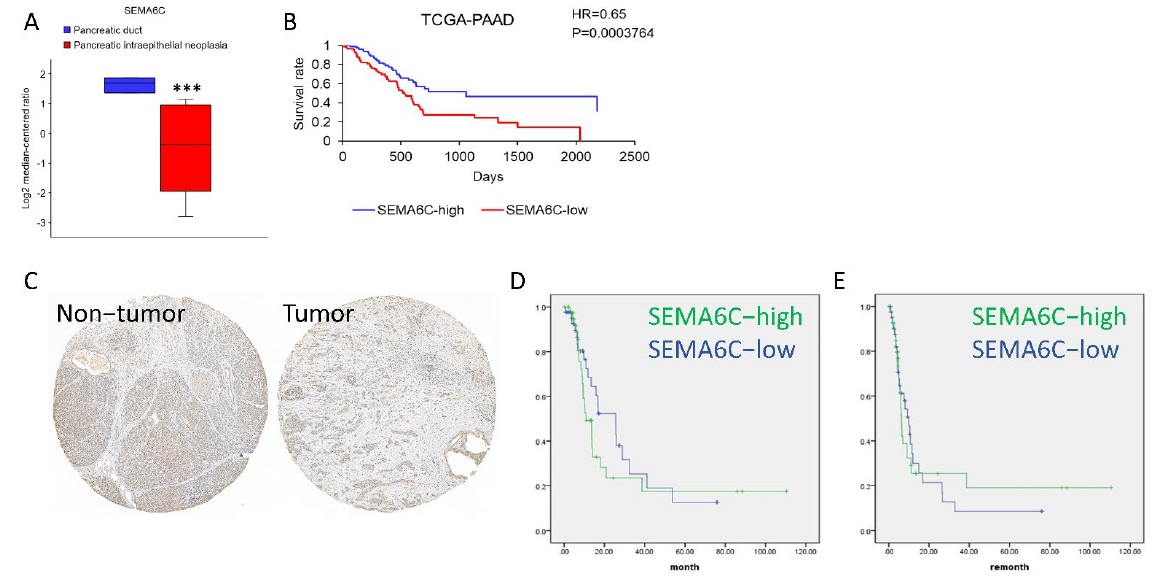
Figure 1. Relation between SEMA6C expression and pancreatic cancer formation. SEMA6C mRNA expression ( A ) and its association with survival ( B ) in pancreatic cancer datasets were analyzed. SEMA6C protein expression ( C ) in the tissue array mentioned above and its relation to overall survival ( D ) as well as disease-free survival ( E ) as shown. For Figure 1B, SEMA6C grouping was based on its median expression (SEMA6C-high n = 31; SEMA6C-low n = 56). For Figure 1D,E, SEMA6C grouping was also based on its mean expression (SEMA6C-high n = 42; SEMA6C-low n = 44). *** p < 0.001.